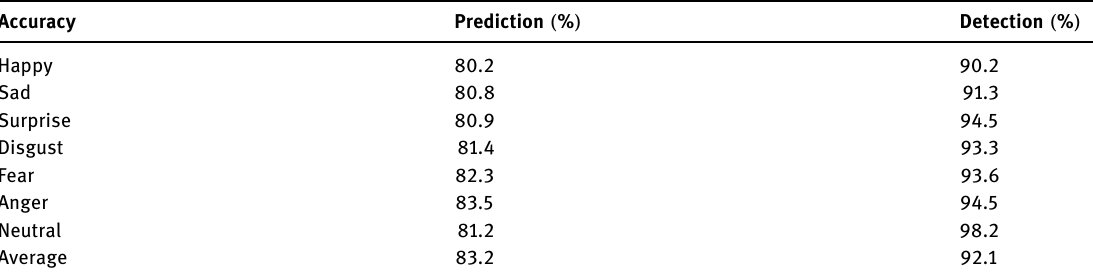
Table 1: The prediction rate and the detection rate